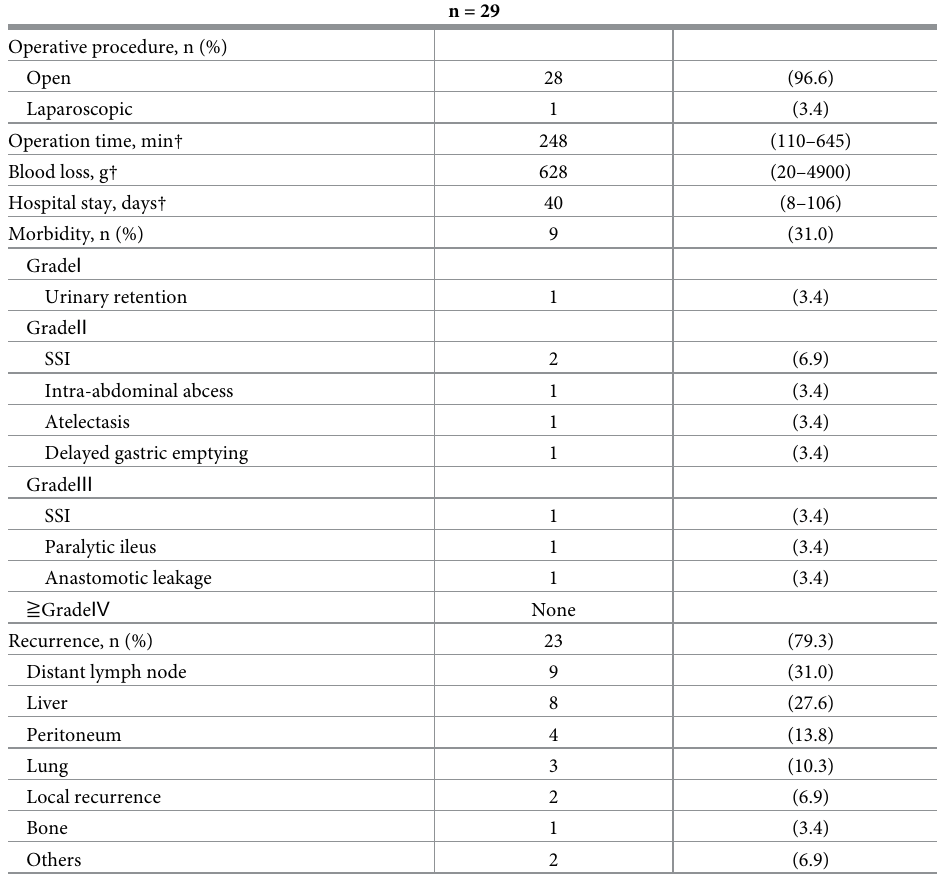
Table 2. Operative and postoperative results.